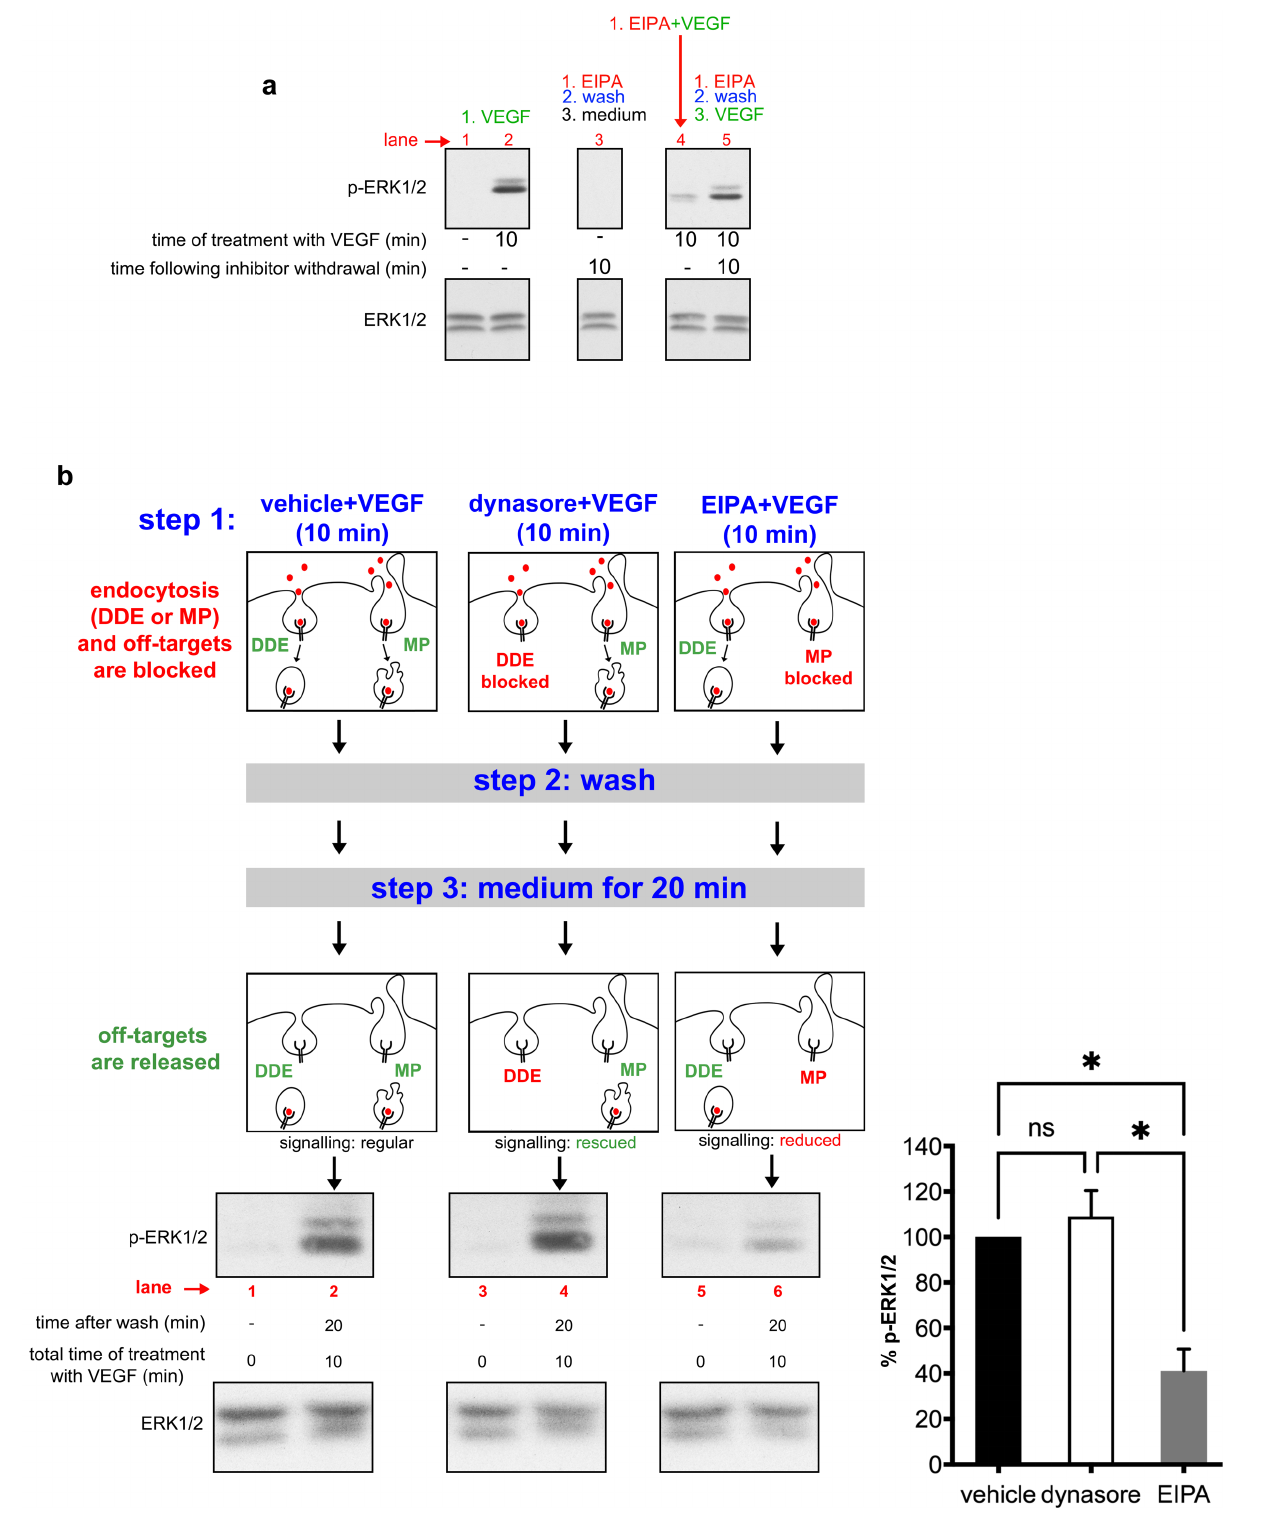
Figure 5. Comparative validation of the specificity of two endocytic inhibitors (dynasore and EIPA) in VEGF-induced phosphorylation of ERK1/2. ( a ) EIPA-mediated inhibition of ERK1/2 phosphorylation is reversible. Serum-deprived